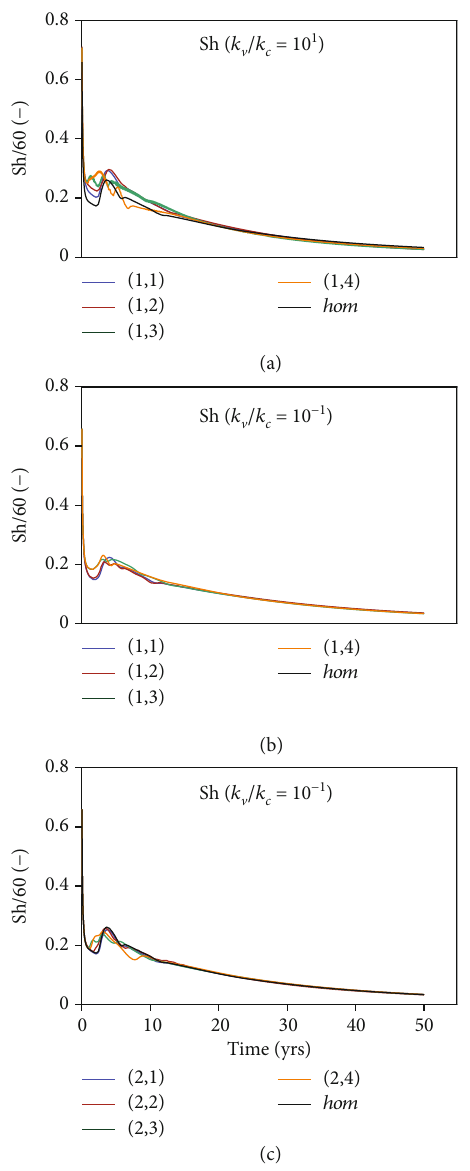
Figure 8: The calculated time-variable Sherwood number (Sh) for simulation cases with di ff erent permeability contrasts and